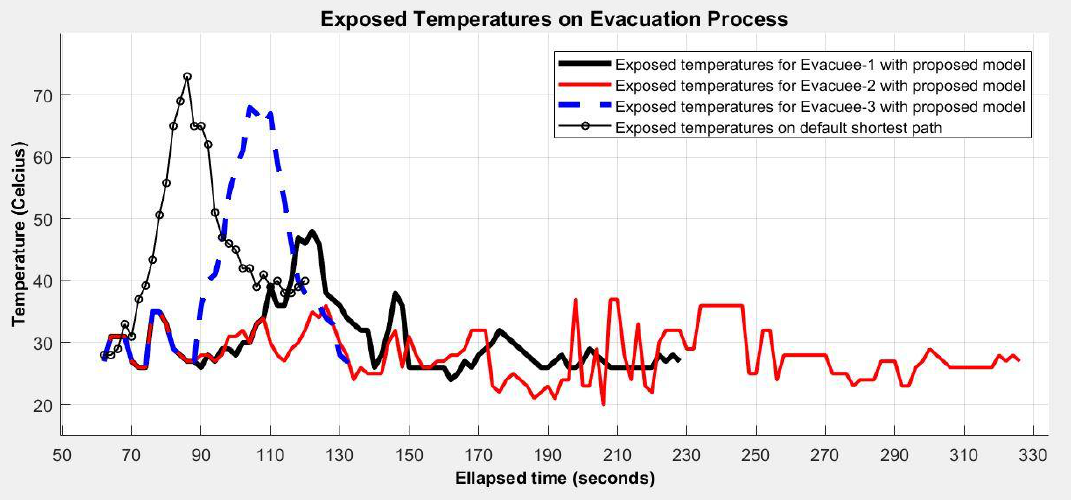
Figure 10. Temperature–time chart. ISPRS Int. J. Geo-Inf. 2018 , 7 , x FOR PEER REVIEW